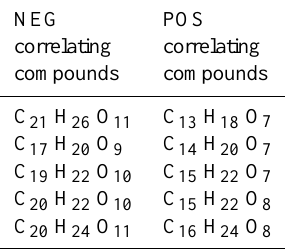
Table 2. Formulas utilized for magnitude summation in order to calculate the degradation index I DEG .